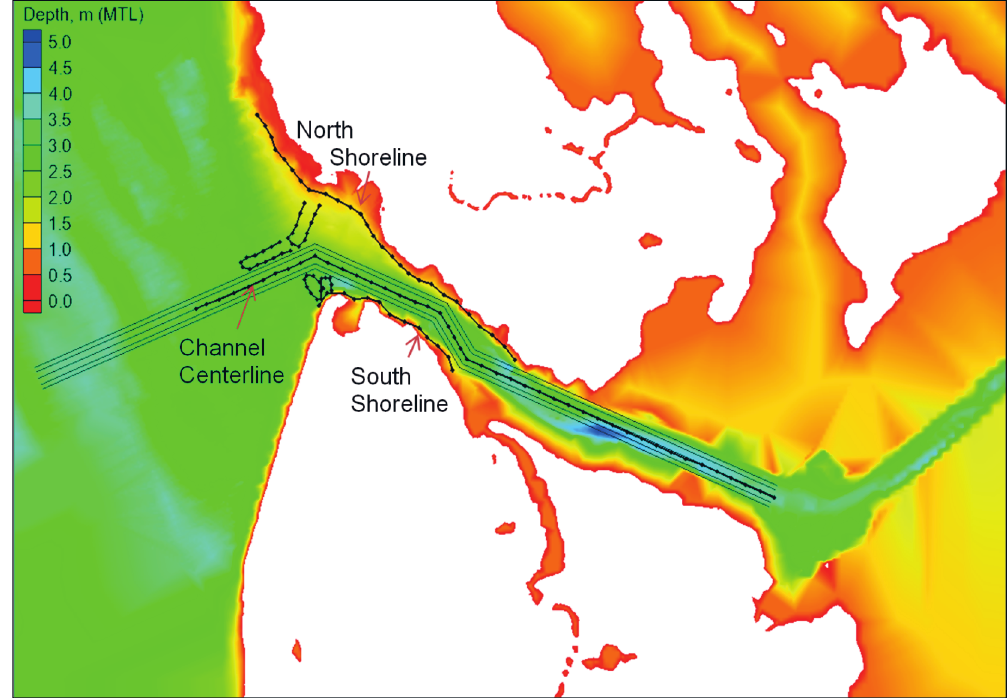
Figure 17. Three transects (lines) used to extract model wave